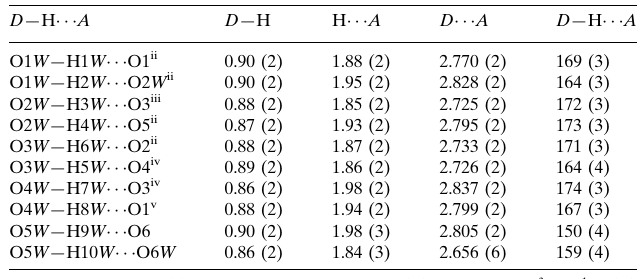
Hydrogen-bond geometry (A˚ , (cid:3)